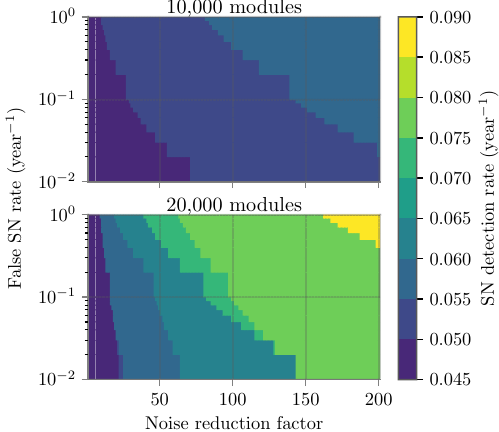
Fig. 10 CCSN detection rate for hypothetical detectors with 10,000 (upper) and 20,000 (lower) mDOMs as a function of the false SN detection rate and a reduction in radioactive noise compared to stan- dard mDOMs. The CCSN detection rates have been calculated using theestimatedCCSNepopulationfrom[16]basedonactualobservations and scaled to the star formation rate are included in the article’s Creative Commons licence, unless indi- cated otherwise in a credit line to the material. If material is not included in the article’s Creative Commons licence and your intended use is not permitted by statutory regulation or exceeds the permit- ted use, you will need to obtain permission directly from the copy- right holder. To view a copy of this licence, visit http://creativecomm ons.org/licenses/by/4.0/. Funded by SCOAP 3 . SCOAP 3 supports the goals of the International Year of Basic Sciences for Sustainable